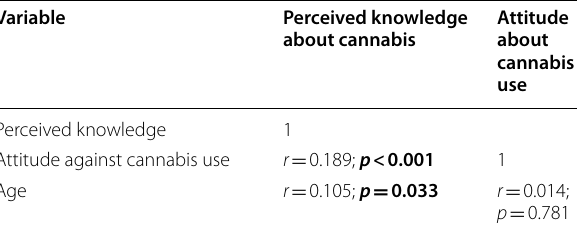
Table 5 Bivariate analysis of continuous factors associated